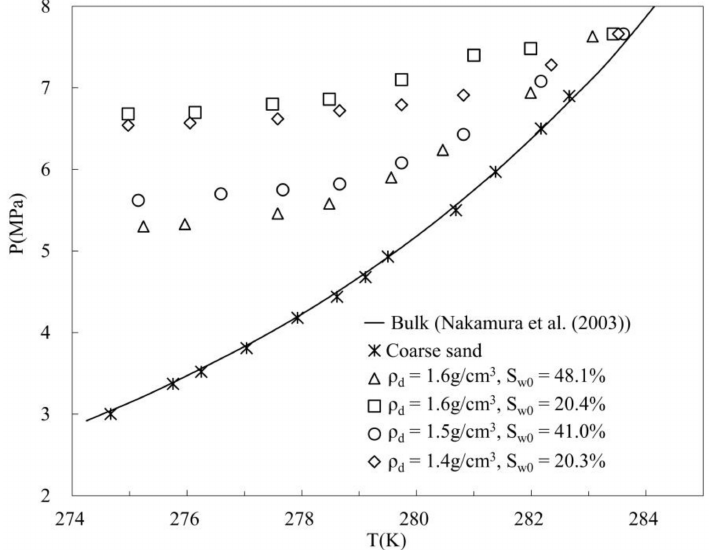
Figure 9. P–T evolution curve of methane hydrate in fine-grained sediment and bulk data